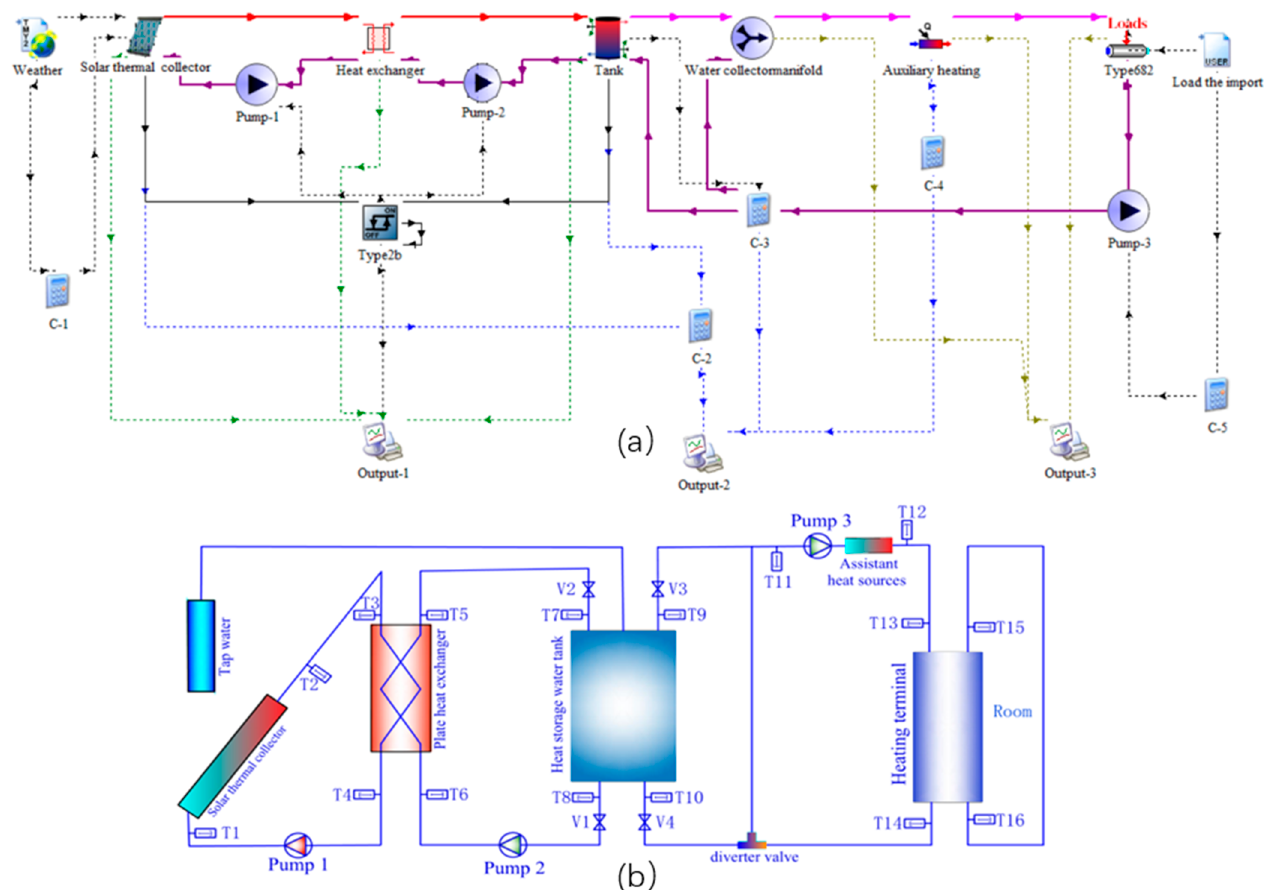
Figure 3. ( a ) TRNSYS dynamic simulation flow chart; ( b ) structure diagram of SHS.